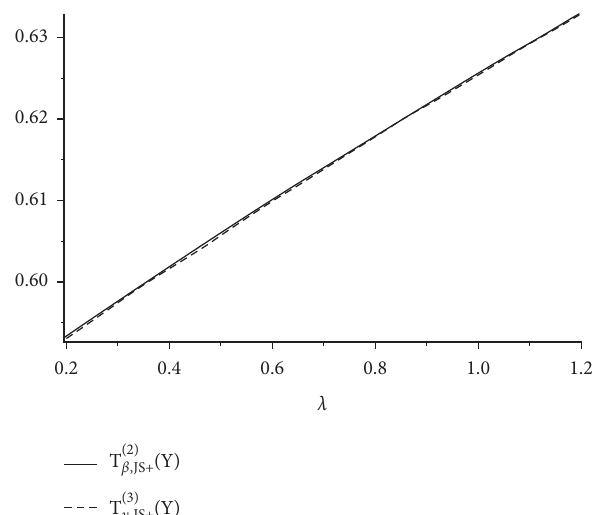
Figure 8: Curves of R